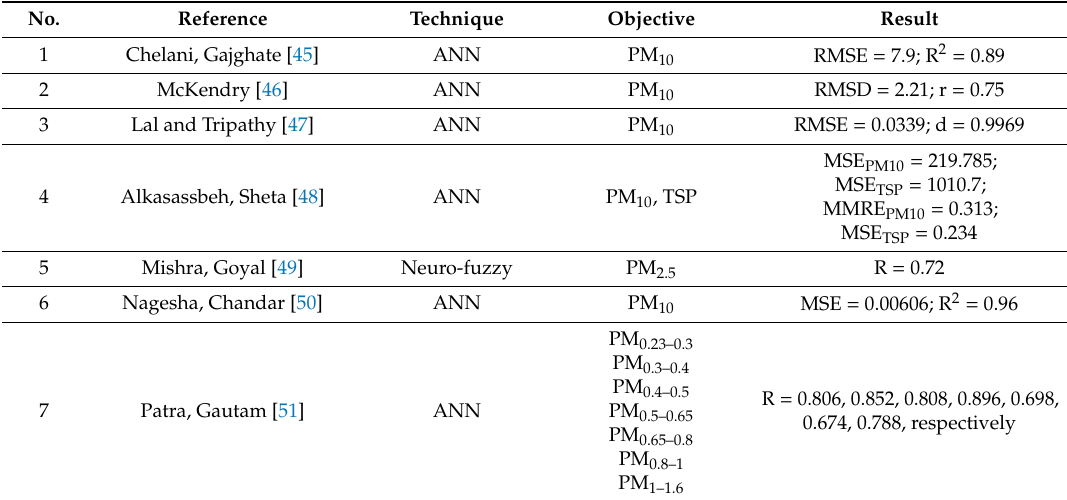
Table 1. Summary of works using AI techniques for predicting PM 10 concentration and